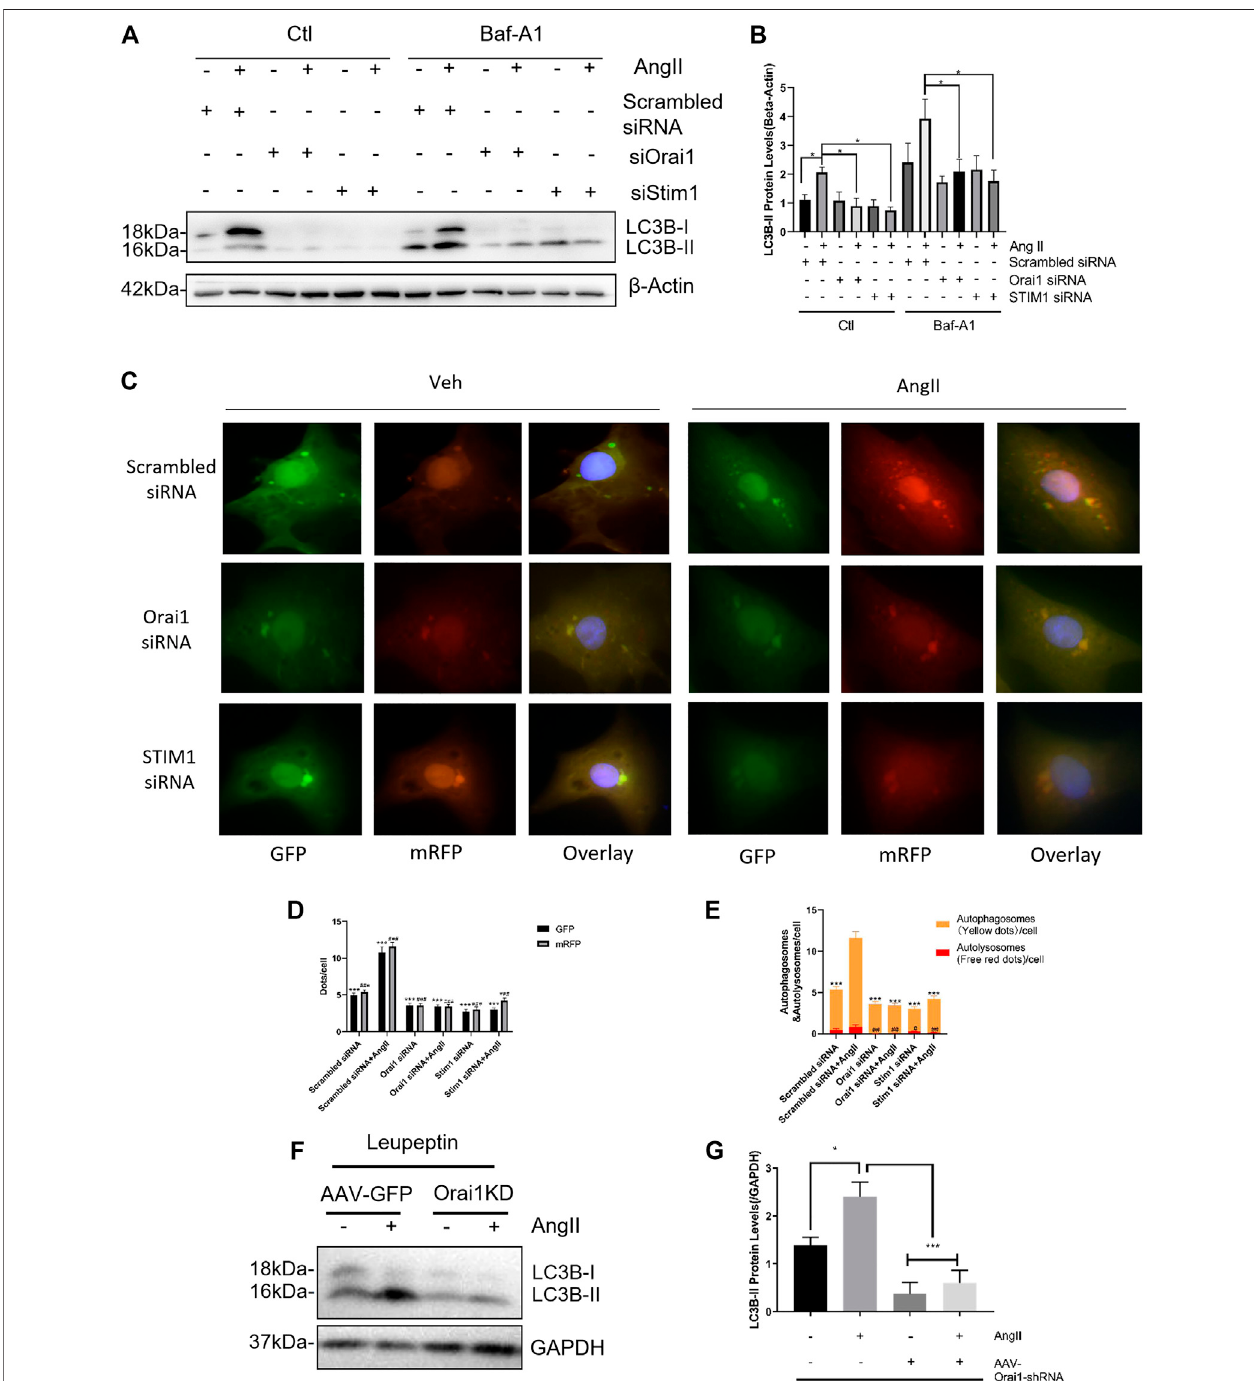
FIGURE 3 | SOCE down-regulates Ang II-induced autophagic fl ux both in vivo and in vitro. SOCE siRNAs did not increase the autophagic fl ux (A, B) After ba fi lomycin A1 (Baf-A1) treatment in NRCM, the representative immunoblots and data summary of LC3B are shown. The effects of Orai1 silencing on LC3-II protein levelsinmice heartswithorwithoutAngIItreatmentareshown (C) NRCMs withorwithoutOrai1orSTIM1knockdownweretransduced withAd-mCherry-GFP-LC3for 48 h, followed by culture in normal or glucose-free medium for 3 h. The representative images of GFP and mCherry dots (C) together with quanti fi cation of autophagosomes and autolysosomes (D, E) are shown (F, G) C57 mice intraperitoneally (i.p.) injected with leupeptin (40 mg/kg) at the indicated doses every two days were sacri fi ced after 28 days. The representative immunoblots and data summary of LC3B are shown. * p < 0.05, ** p < 0.01, and *** p < 0.001.